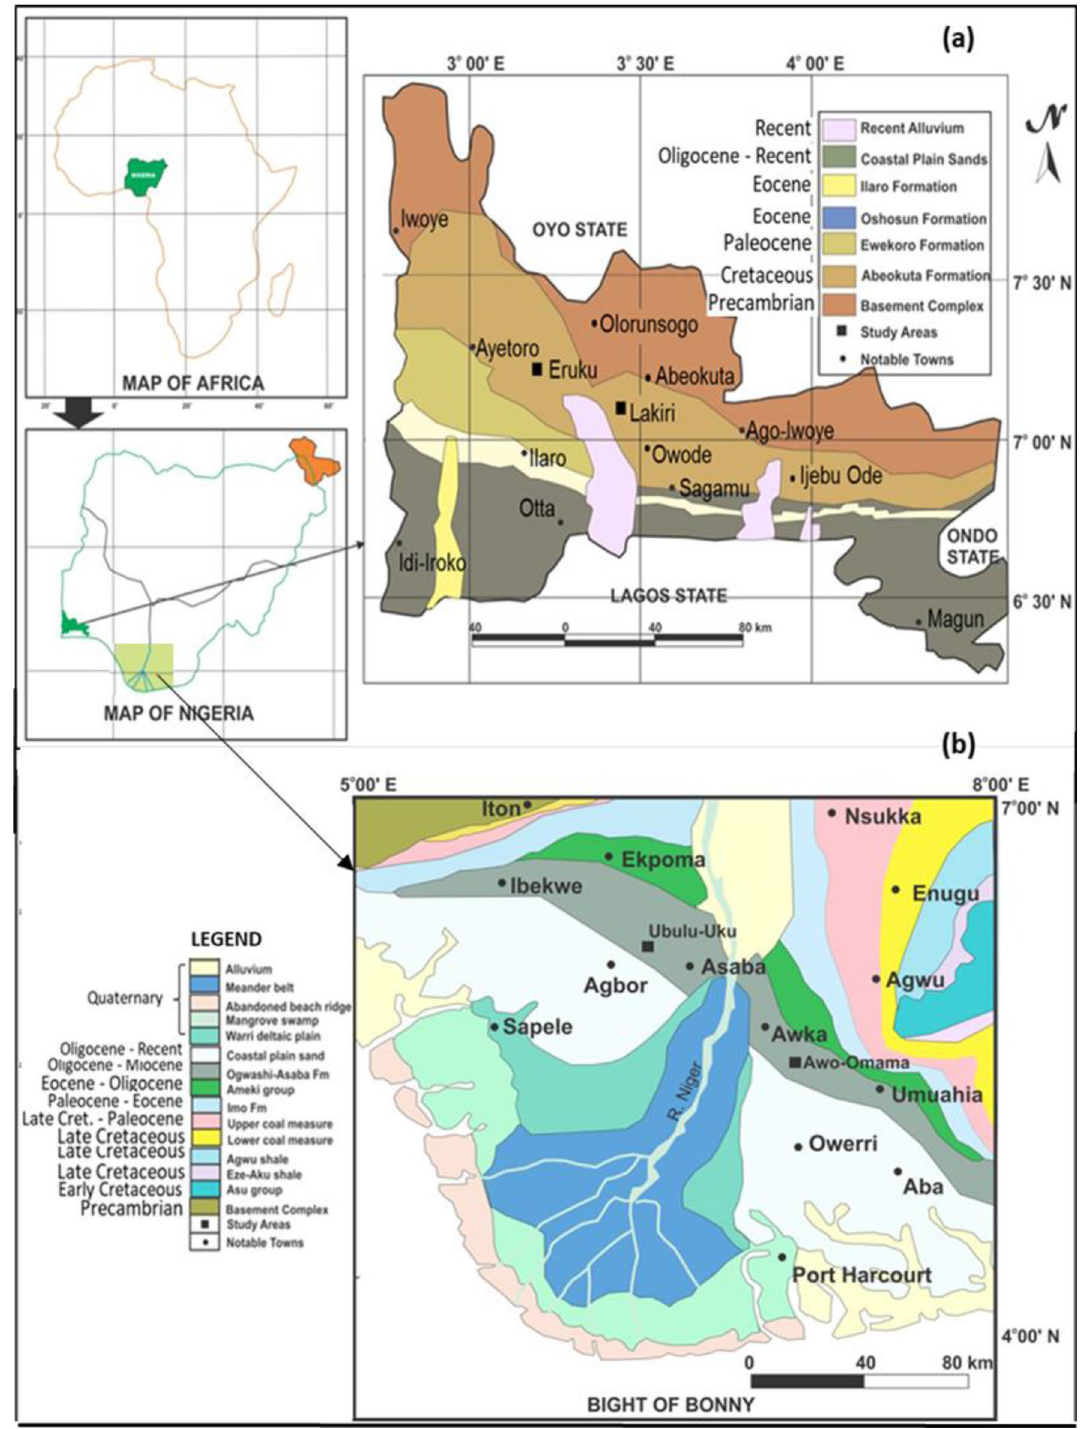
Figure 2. Geologic maps of ( a ) Eastern Dahomey and ( b ) Niger Delta Basins showing the study areas (Modified after 16